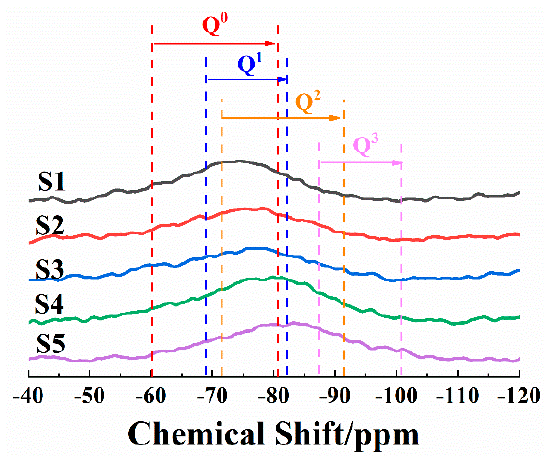
Figure 3. 29 Si NMR spectra of S1–S5.